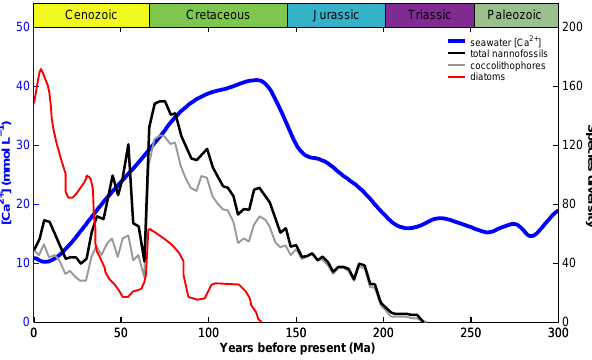
Figure 1. Seawater Ca 2 + concentration and fossil phytoplank- ton diversity over the past 300Myr. Model-reconstructed seawater Ca 2 + concentration (blue line; data retrieved from Hönisch et al., 2012), fossil species diversity of diatoms (red line; data retrieved from Kooistra et al., 2007), total nannofossils and coccolithophores (black and grey line, respectively; data retrieved from Bown et al.,